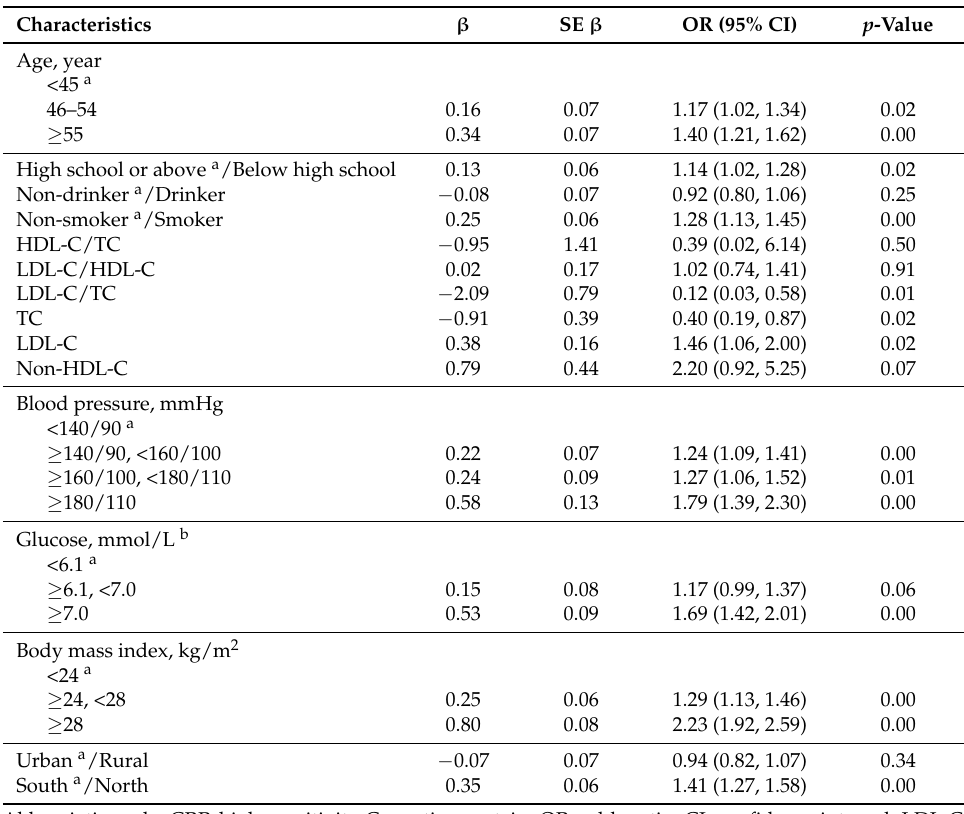
Table 4. Relationship between hs-CRP concentrations and the corresponding cardiovascular risk factors.